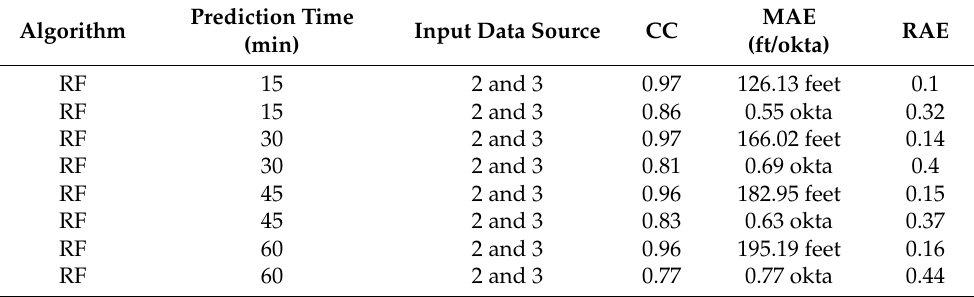
Table 10. Better statistical results of short-term H c /C q forecast using regressive algorithms, whose training was performed using the data set with configuration (5), whose records were divided as Auto-WEKA default.